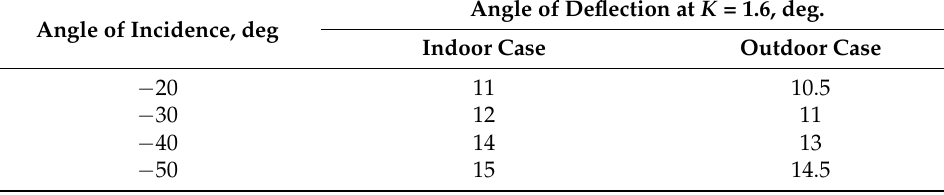
Angle of Deflection at K = 1.6,